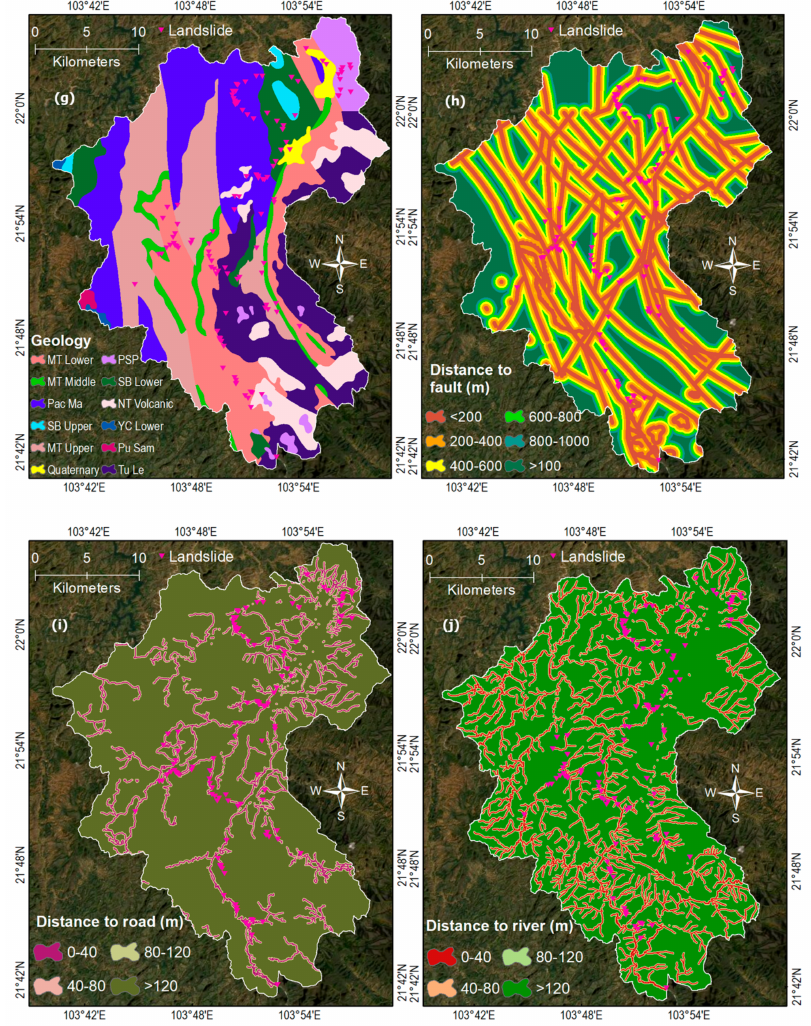
Figure 3. Landslide influencing factors: ( a ) elevation; ( b ) slope; ( c ) curvature; ( d ) aspect; ( e ) relief amplitude; ( f ) soil type; ( g ) geology; ( h ) distance to fault; ( i ) distance to road; and ( j ) distance to